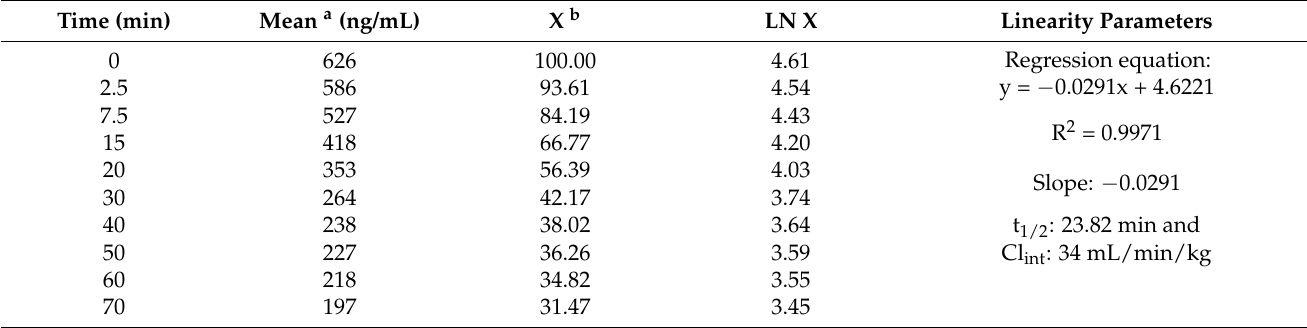
Table 3. SLP metabolic